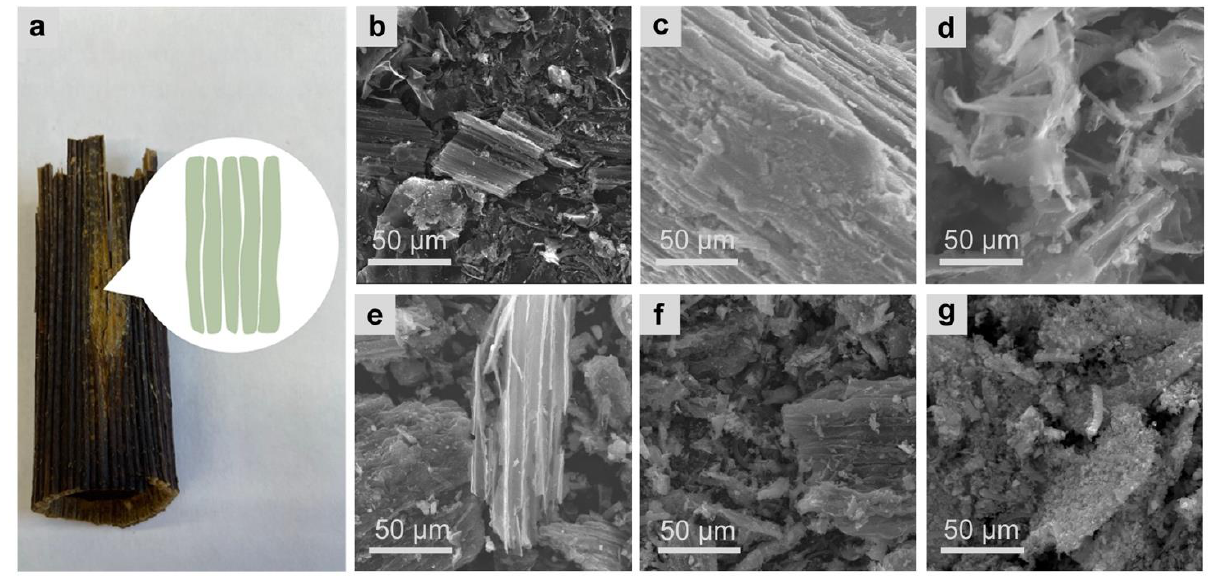
Figure 3. Dry stem of hogweed ( a ); SEM images of hard carbonsSH-1300 ( b ); WH-A200-1300 ( c ); WH-H200-1300 ( d ); SH-1300 ( e ); SH-A200HCl-1300 ( f ); SH-H200-1300 ( g ).